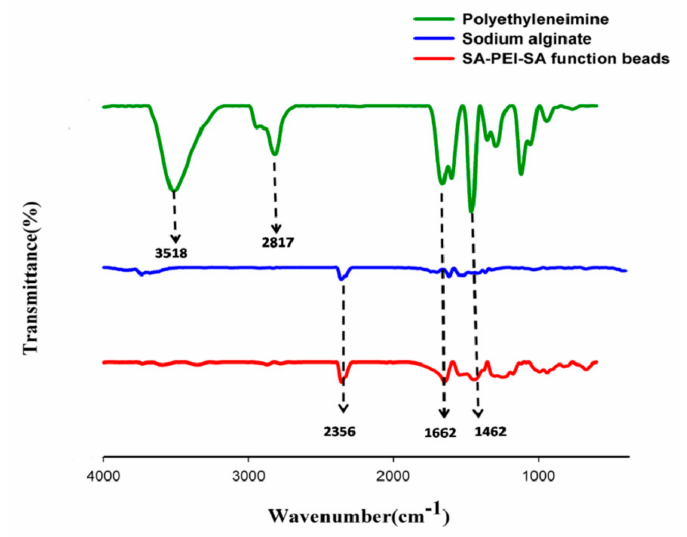
Figure 2. Fourier transform infrared (FTIR) spectra of PEI, SA and SPS